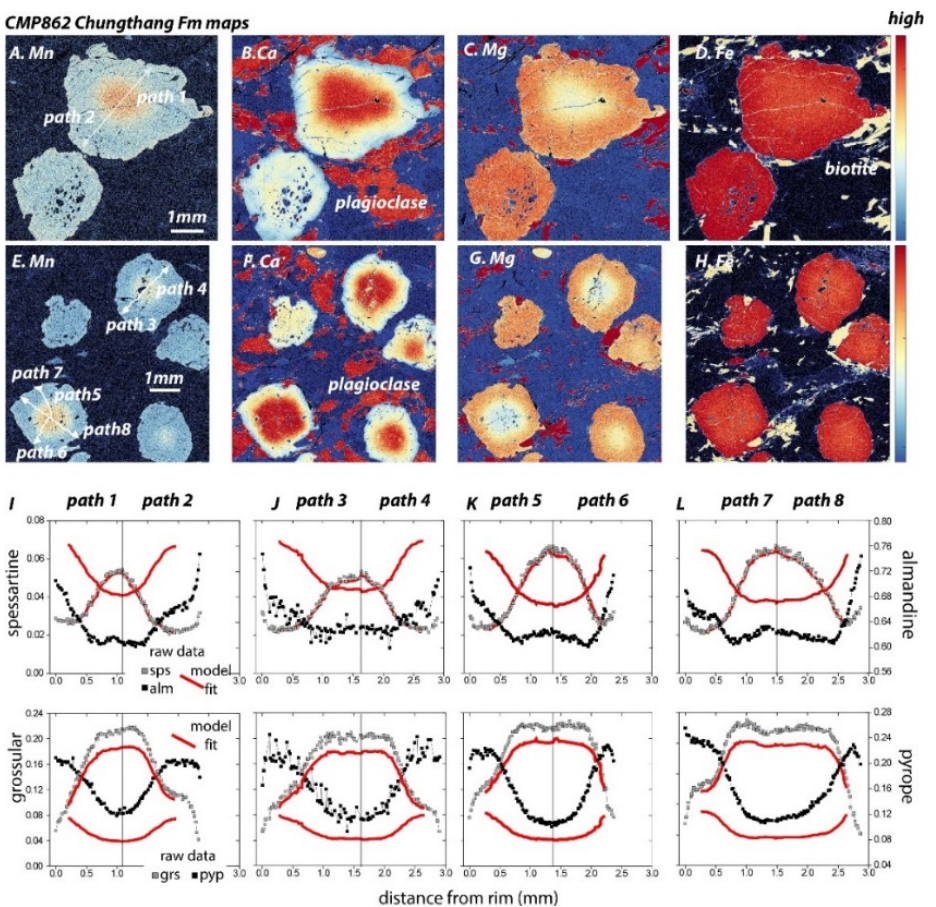
Figure 8. X-ray element maps of sample CMP862 (Chungthang Fm) in in ( A ) and ( E ) Mn, ( B ) and ( F ) Ca, ( C ) and ( G ) Mg, and ( D ) and ( H ) Fe. Garnet compositions in spessartine (sps) and almandine (alm) ( upper panels E – L ) and grossular (grs) and pyrope (pyp) ( lower panels I – L ) were taken across the rim to rim transects identified in panels ( A , E ). The red lines in panels ( I – L ) show the prediction of the high-resolution P-T paths generated for this sample.